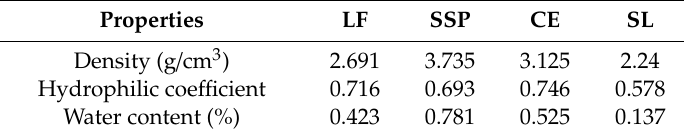
Figure 1. Appearances of the four fillers. Table 2. Basic properties of four powders.